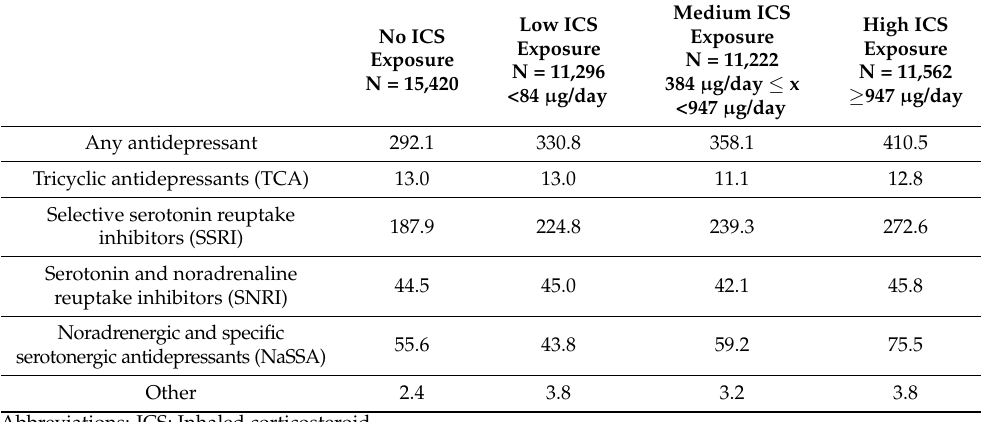
Table A3. Number of WHO-defined daily doses collected of antidepressant per 1000 patient study days.